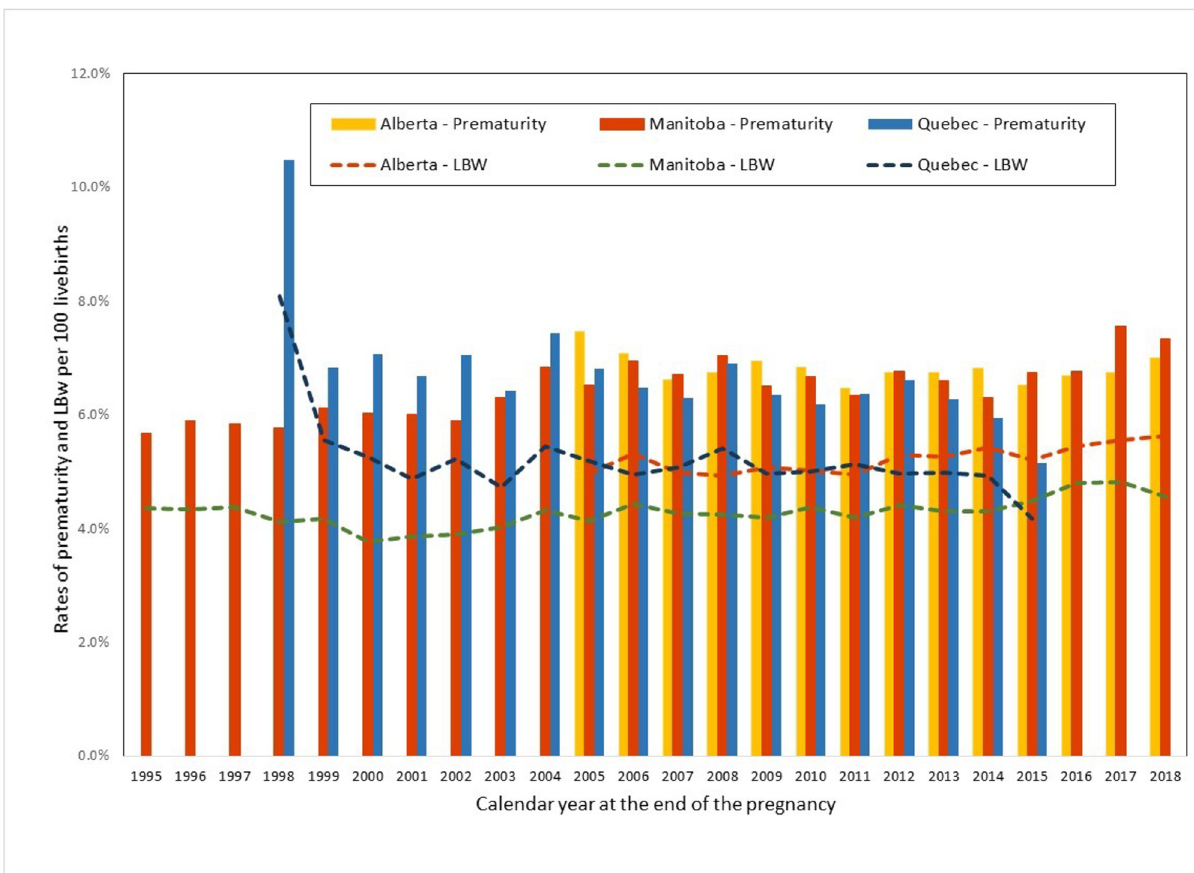
Fig 1. CAMCCO—Quebec, Manitoba, Saskatchewan, and Alberta—Annual rates of prematurity and low birth weight (LBW). Annual rates of prematurity and LBW during the study period in Quebec, Manitoba, Saskatchewan, and Alberta. Note: Data on preterm births were missing from SK’s birth abstracts for the years 1996–2000; and birthweight was missing for the years 1996–98 for live births.